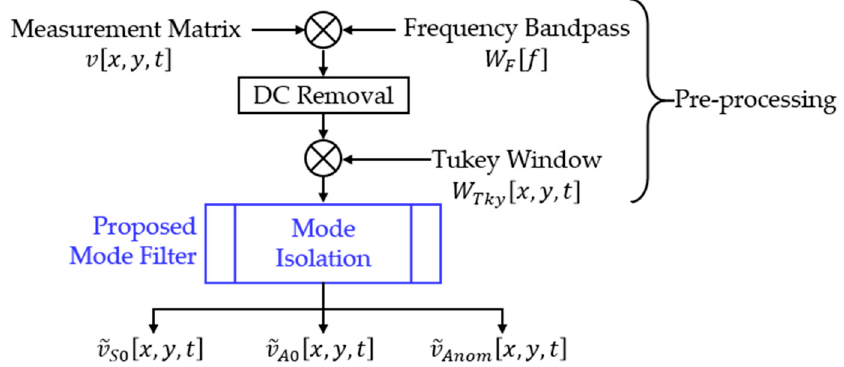
Figure 1. Flow diagram of a typical mode isolation process.